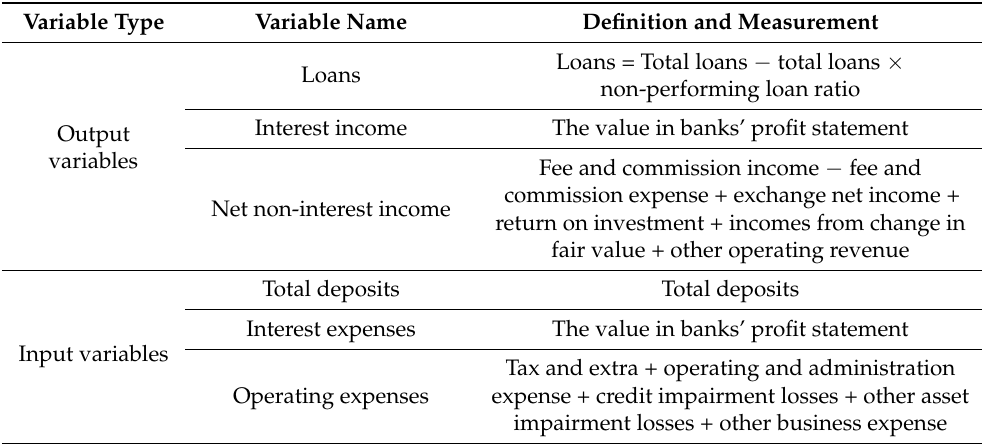
Table 1. Input and output variables of